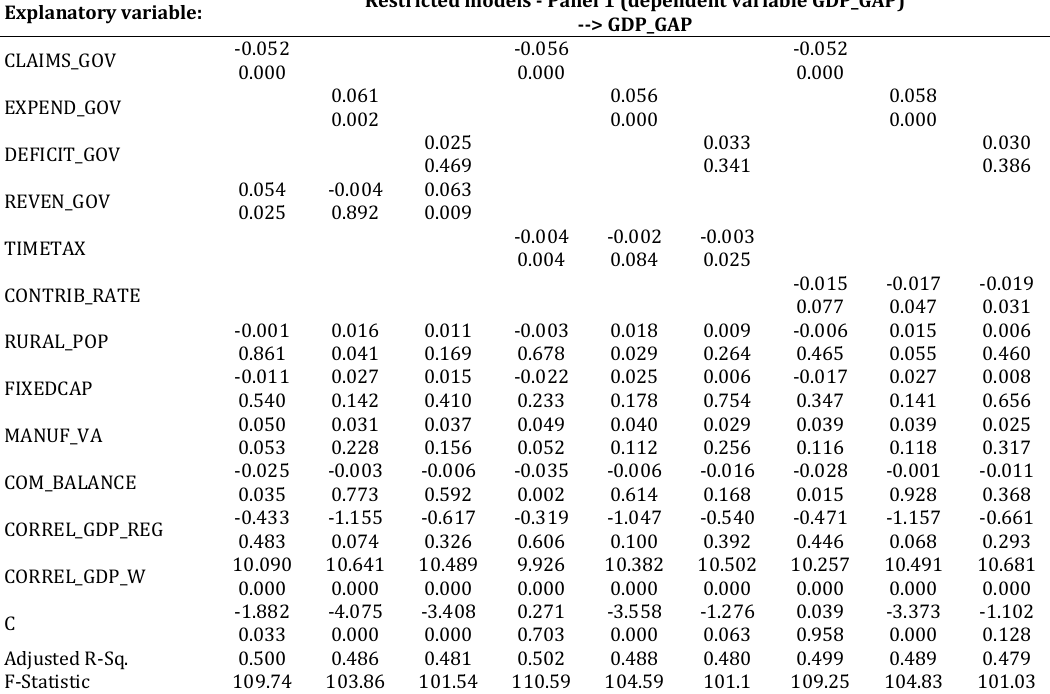
Table 2: Restricted model – Panel 1 (GDP_GAP dependent